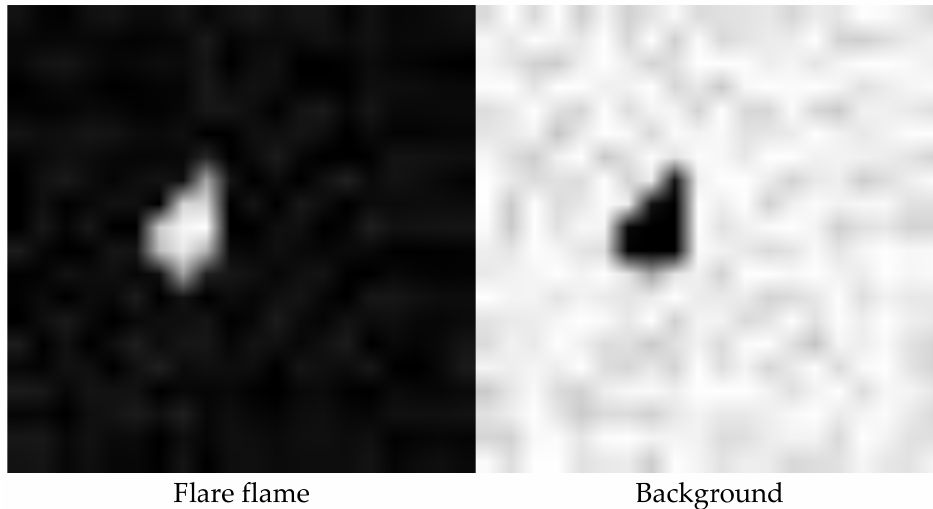
Figure 6. The considered abundance